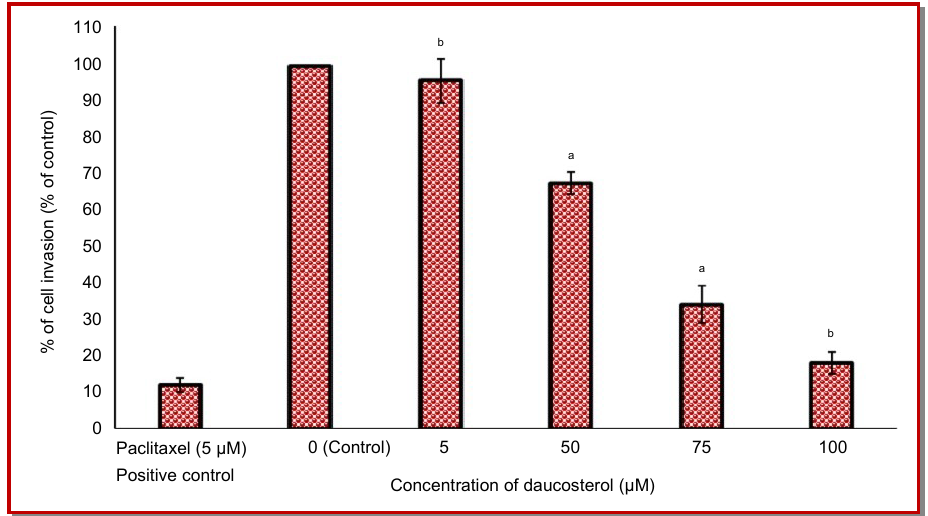
Figure 3: Daucosterol inhibits cell migration ability in HCT-116 colon cancer cells in a dose-dependent manner. Paclitaxel at a dose of 5 µM was used as a positive control. Data are shown as the mean ± SD of three independent experiments. a p<0.05, b p<0.01, vs 0 µM (control)